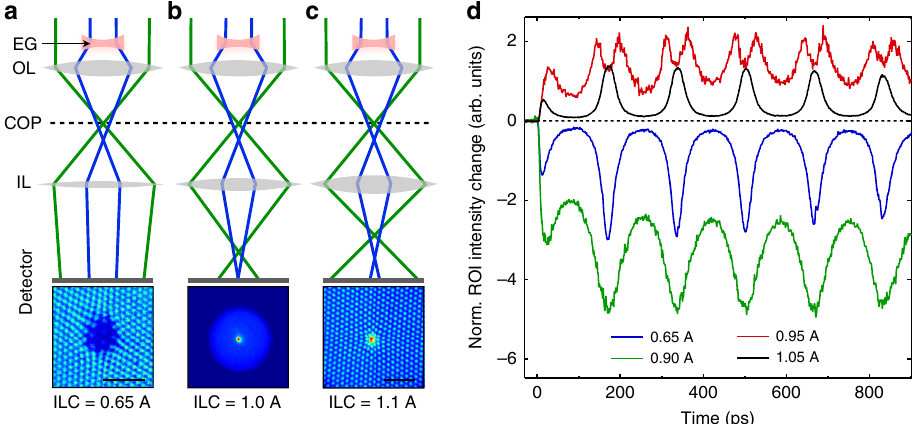
Fig. 5 Dependence on the intermediate lens strength. a – c Image conditions with various intermediate lens currents (ILC): a 0.65 A, underfocus regime, barrel distortion, b 0.95 A, in-focus regime, c 1.1 A, overfocus regime, pincushion distortion. The corresponding images are shown at the bottom ( Δ t = 173 ps, OL current 0.7 A). Since the electron gas (EG, red) acts like a diverging lens, the probe electrons that pass through the gas (blue) are focused by the objective lens (OL) after/below the probe electrons that are not affected by the electron lens (green). COP = crossover plane. The scale bars are 50 μ m (no scale bar for image in b , since the grid is not visible). In this fi gure, all the projection lenses after the sample are replaced by one equivalent lens (labeled IL). Only the IL strength was changed. The copper grid is not shown for simplicity. d ROI difference intensity traces for various ILC values (OL current 0.7 A).